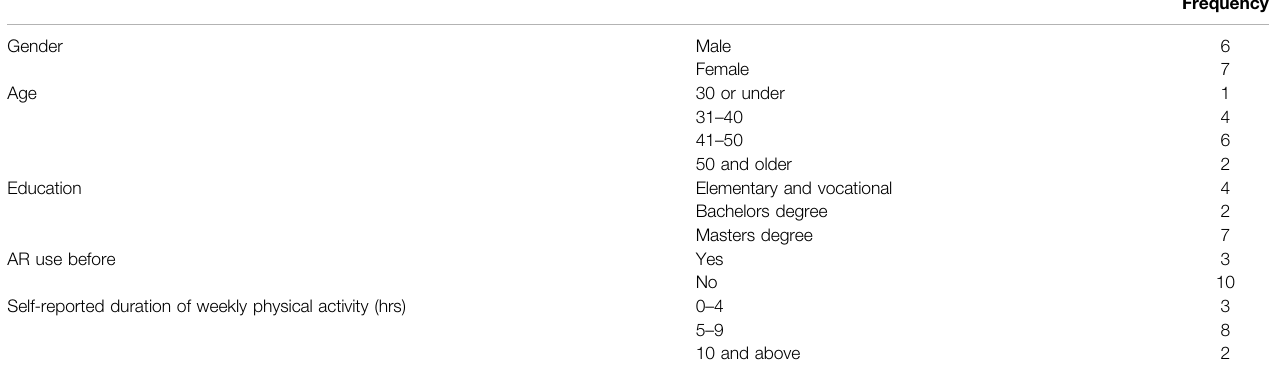
TABLE 1 | Respondent